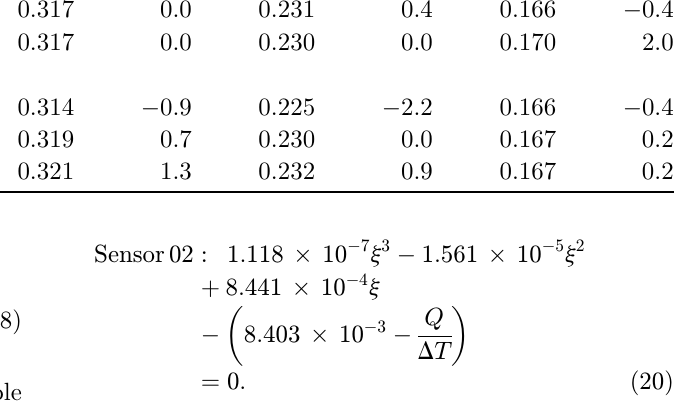
Table 5. Thermal conductivities of the samples by the developed model (in W/m ° C) at 20 ° C.